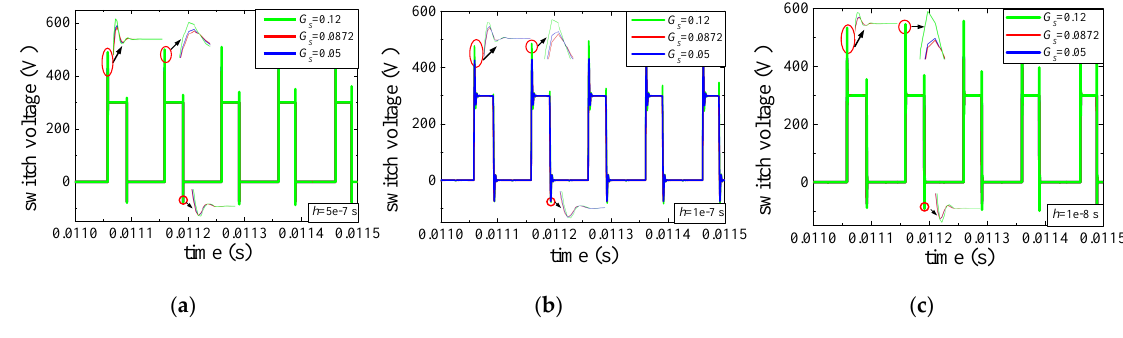
Figure 6. Switching voltage: ( a ) h =5e-7 s; ( b ) h =1e-7 s; ( c ) h =1e-8 s.